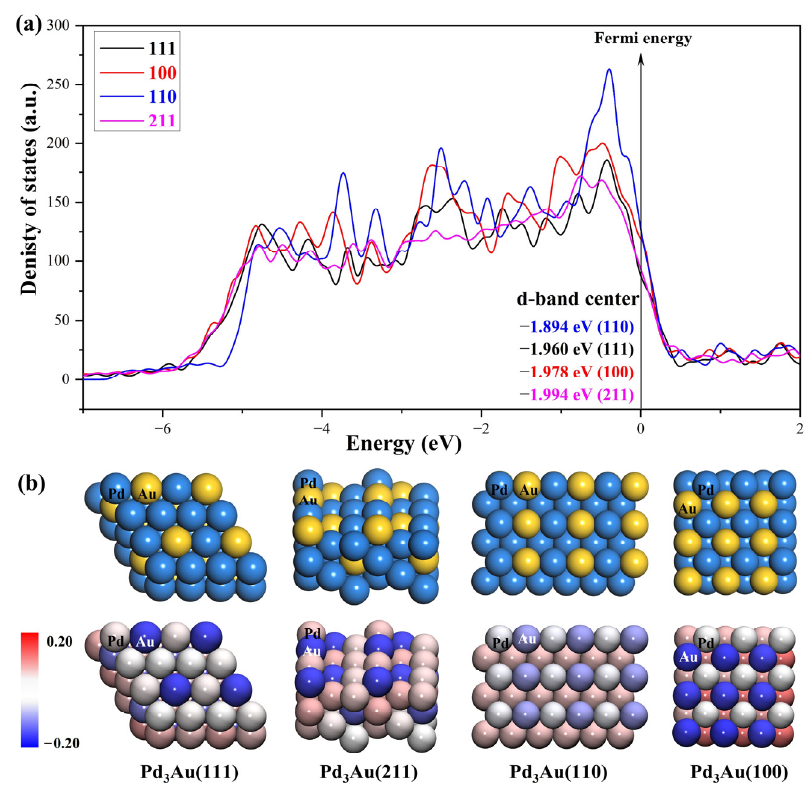
Figure 3. ( a ) d-orbital density of states of the Pd 3 Au (111), (100), (110), and (211) surfaces. ( b ) The optimized structures of different Pd 3 Au surfaces. Slab geometries with each atom are colored by the magnitude of their Bader charges.